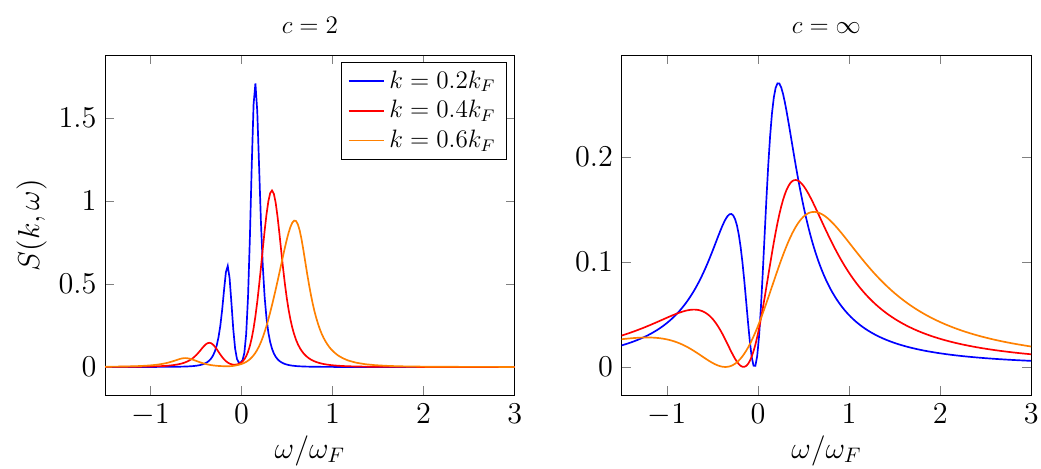
Figure 6: Dependence of the dynamic structure factor S ( k , ω ) of the post-quench diagonal = k 2 ensemble (39) on the frequency ω/ω with the Fermi energy ω , for three values of the F F F wave-vector k = 0.2 k , 0.4 k , and 0.6 k . The left and the right panels correspond to a quench F F F to c = 2 and c → ∞ , respectively. In the left panel the curves are obtained via a numerical computation with the ABACUS code for N = L = 20 and c = 2 while in the right panel the curves correspond to the analytic prediction for the case c → ∞ in the thermodynamic limit N → ∞ , L → ∞ with n = 1, derived in Ref. [ 64 ]